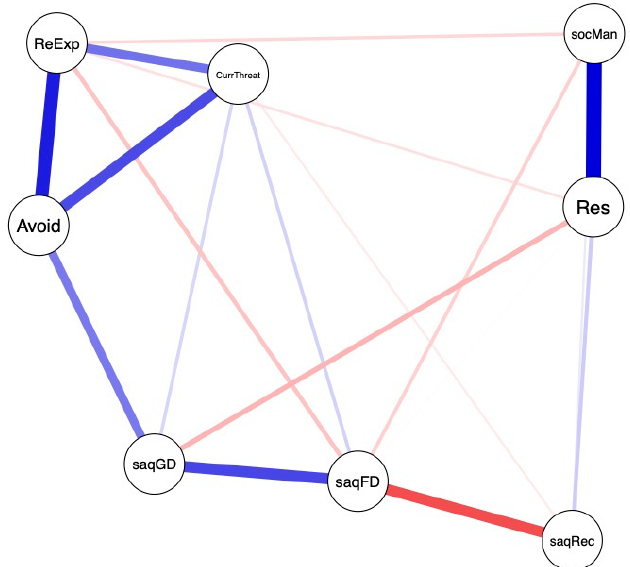
Figure 1. Estimated network of the RMRF Gaussian graph model. Note. ReExp = PTSD symptoms of re-experiencing, Avoid = PTSD symptoms of avoidance, CurrThreat = PTSD symptoms of perception